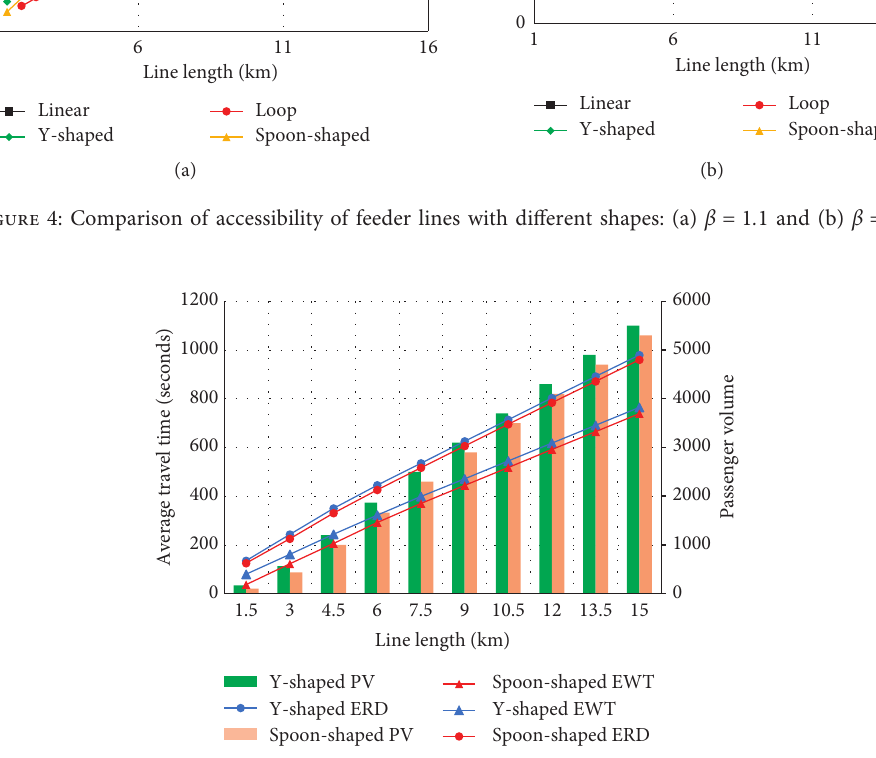
Figure 5: Comparison of Y-shaped lines and spoon-shaped lines (PV: passenger volume; EWT: average waiting time; ERD: average riding time).